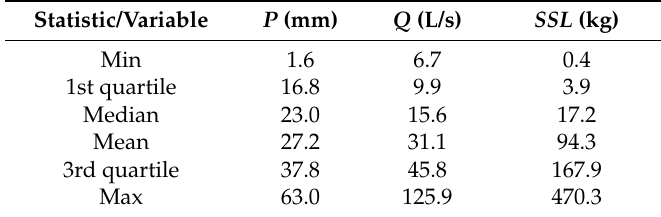
Table 2. Summary statistics of the defined variables for the data from the Kuzlovec